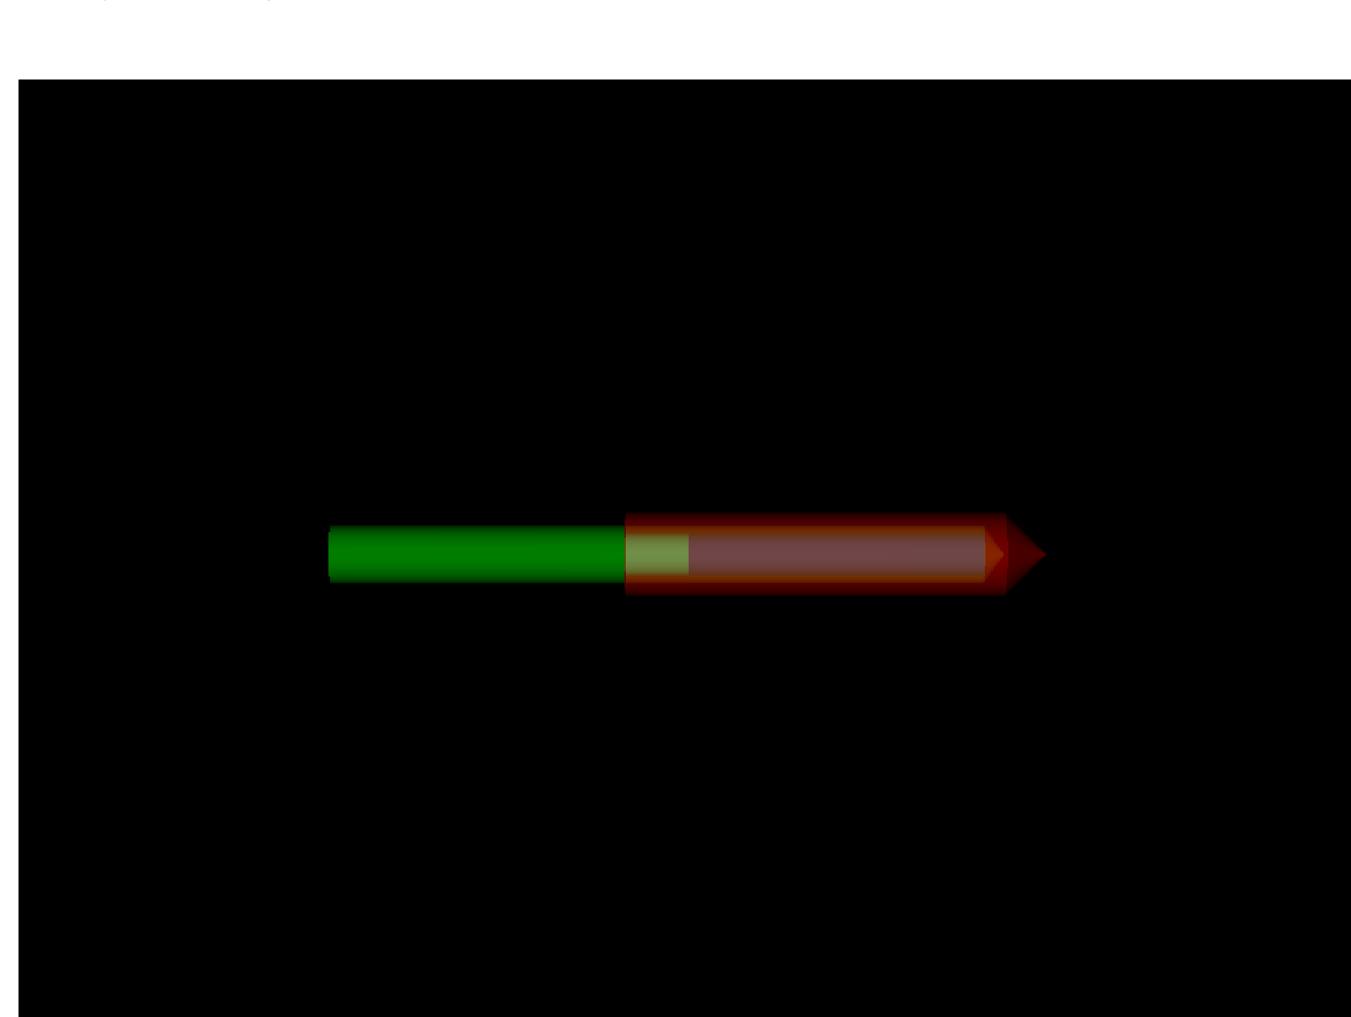
Fig 2. Simulation geometry of the BEBIG 60 Co source. The figure was obtained using the egs-_view in the egs++ code.